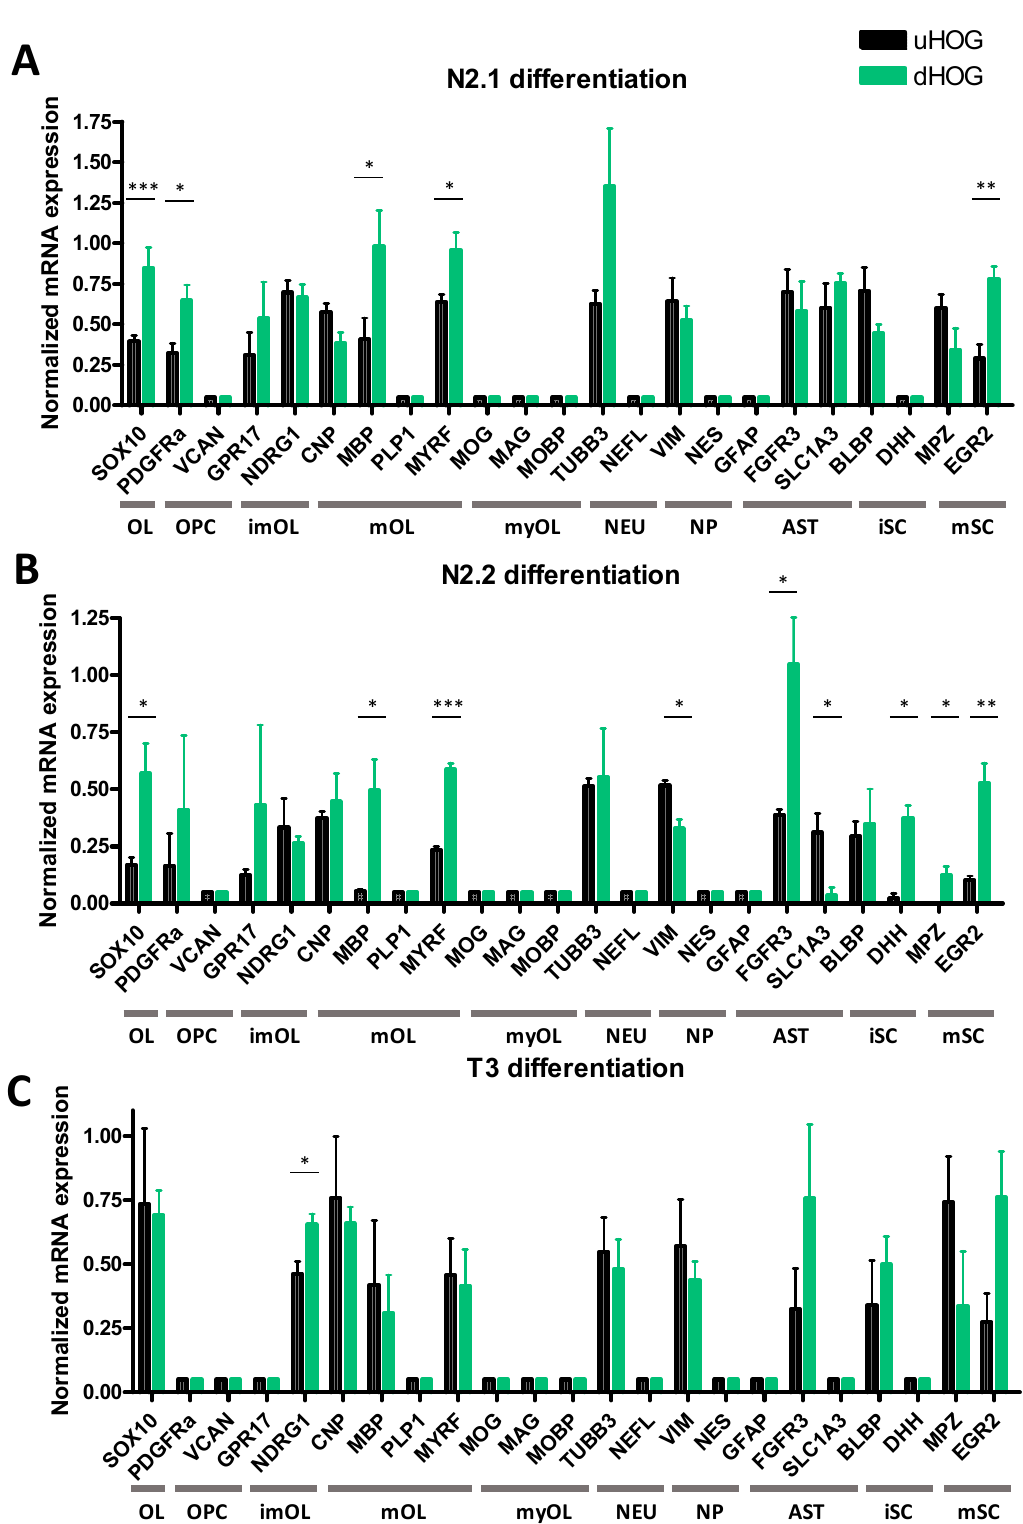
Figure 1. Normalized mRNA expression in undi ff erentiated HOG cells (uHOG) and HOG cells following di ff erentiation (dHOG) with ( A ) N2.1 medium, ( B ) N2.2 medium or ( C ) T3 medium. OL: oligodendrocyte lineage, OPC: oligodendrocyte precursor, imOL: immature oligodendrocyte, mOL: mature oligodendrocyte, myOL: myelinating oligodendrocyte, NEU: neuronal, NP: neural progenitor, AST: astrocyte, iSC: immature Schwann cell, mSC: mature Schwann cell. Independent samples t -tests are based on triplicates in three independent experiments ( n = 3). p -values: * < 0.05, ** < 0.01, *** < 0.001.